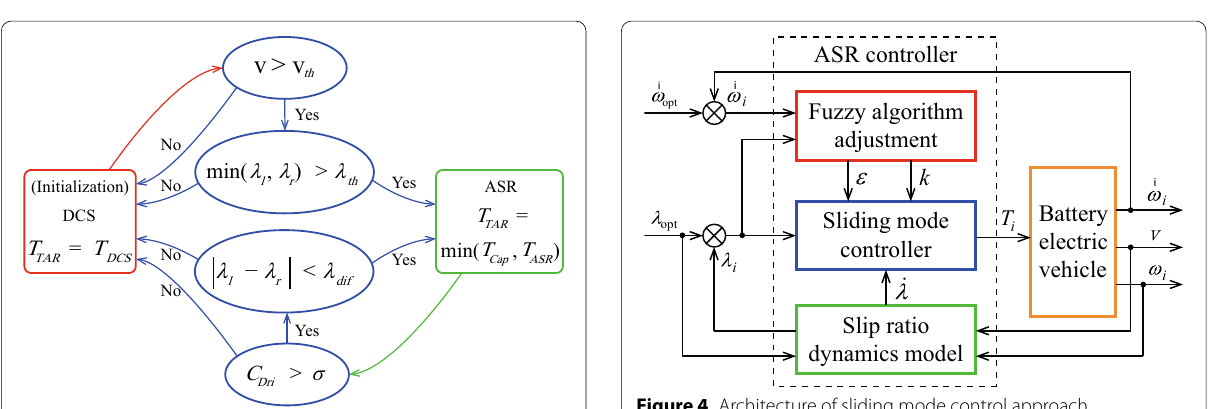
Figure 3 Traction torque control of acceleration slip regulation